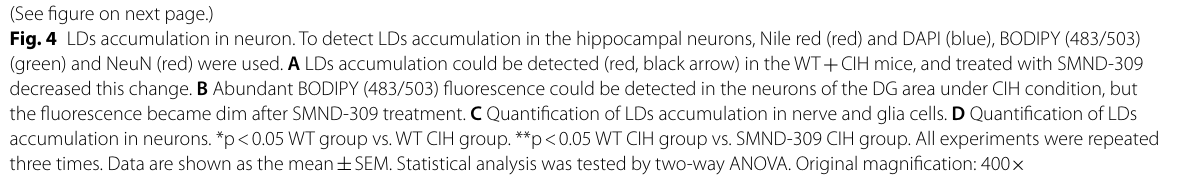
Fig. 3 Pathological changes of DG area. A H&E staining of the hippocampus. In the SGZ of the WT arrow), but SMND-309 treatment relieved the damage. Original magnification: 400 WT CIH group exhibited cytoplasmic vacuolization, LDs accumulation (black arrow) and mitochondrial disruption (black triangle). Moreover, + glial cells of the WT CIH group presented edema (black star), especially in the area surrounding the BBB. Original magnification: 15,000 + experiments were repeated three times